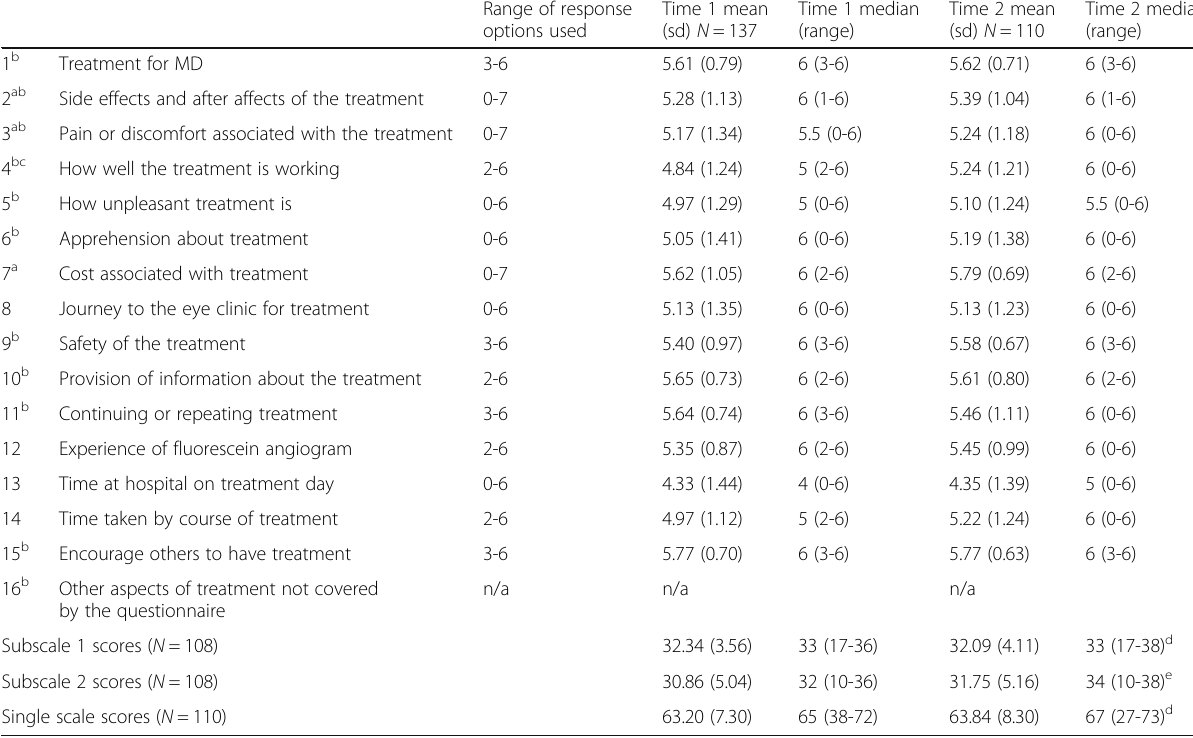
Table 1 Range of response options used at time 1 and mean scores for each item. Subscale and single scale means and medians at time 1 and time 2 and comparison of time 1 and time 2 scores